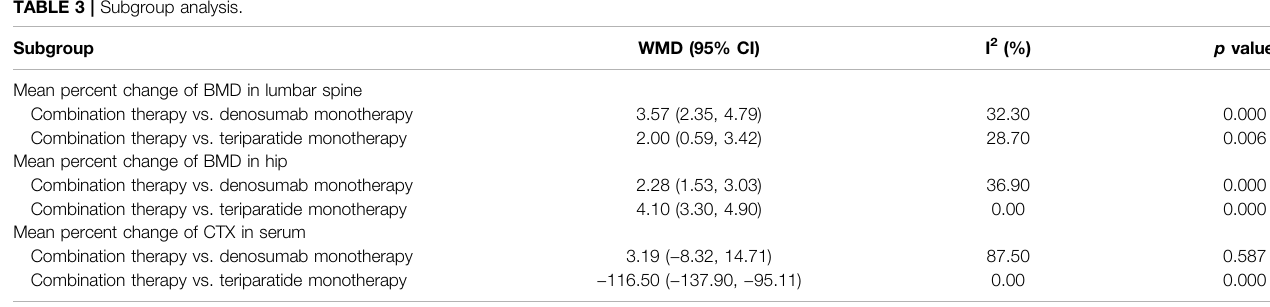
TABLE 3 | Subgroup